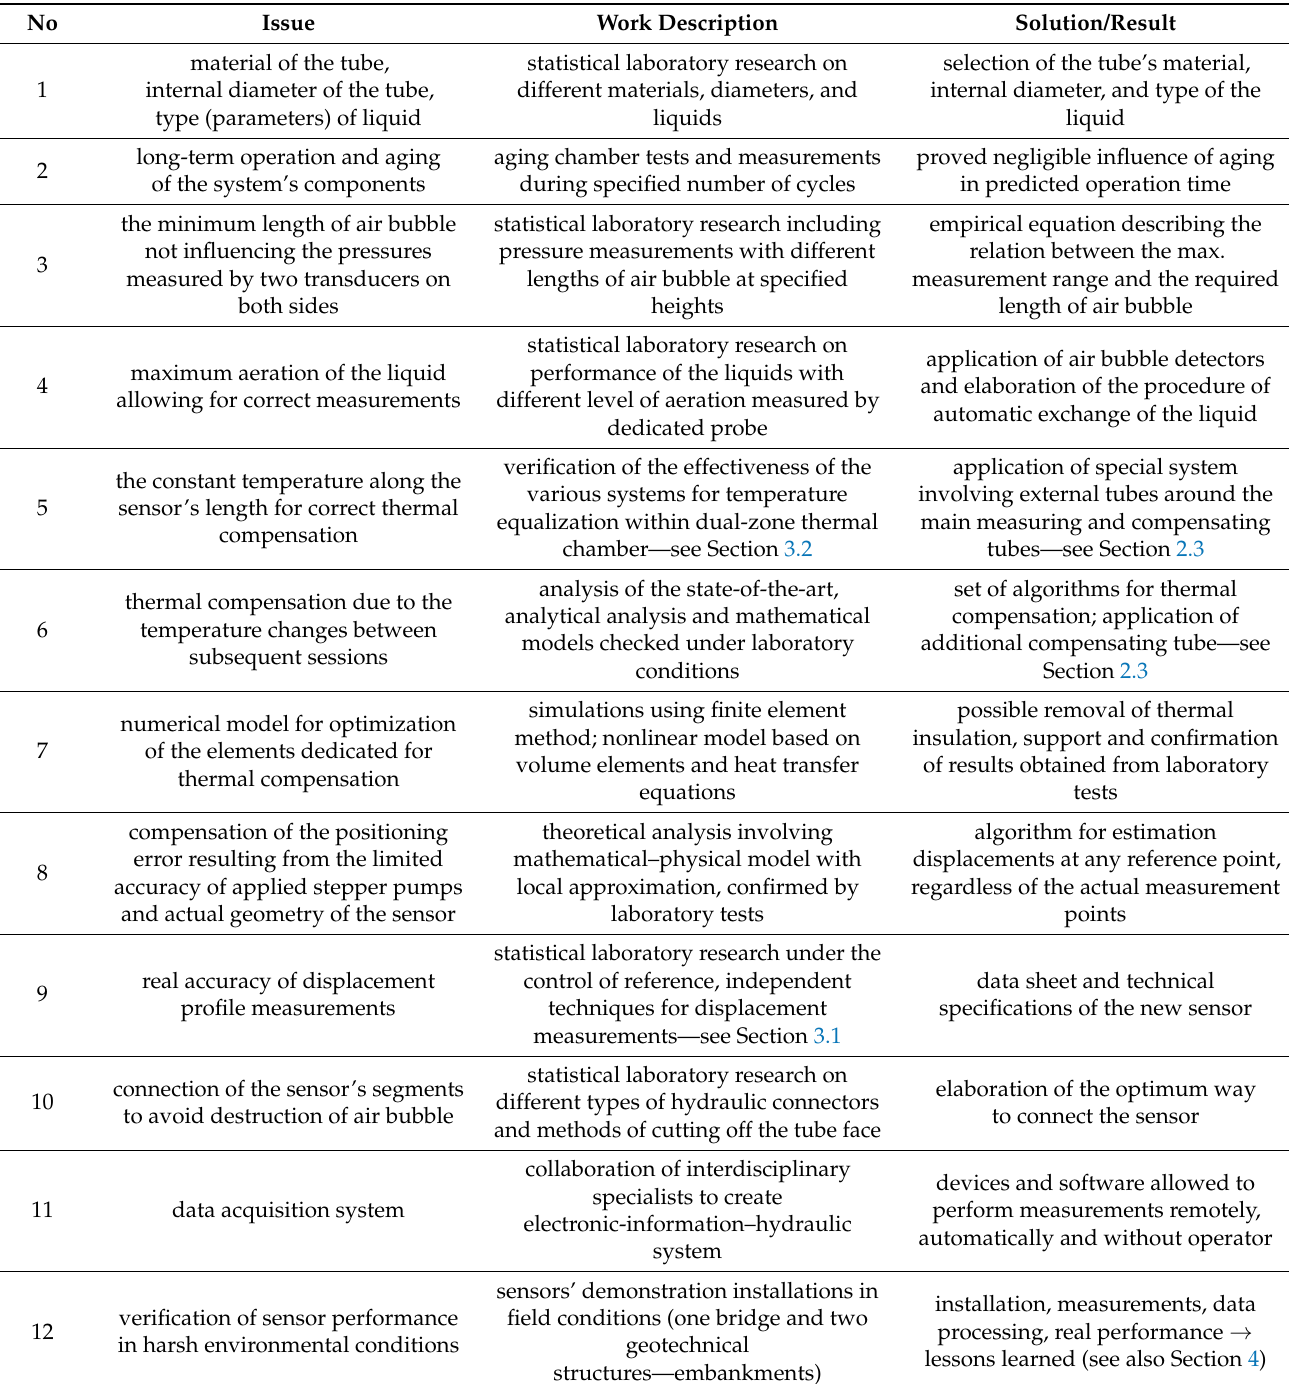
Table 1. Issues addressed during the development of new hydraulic and distributed